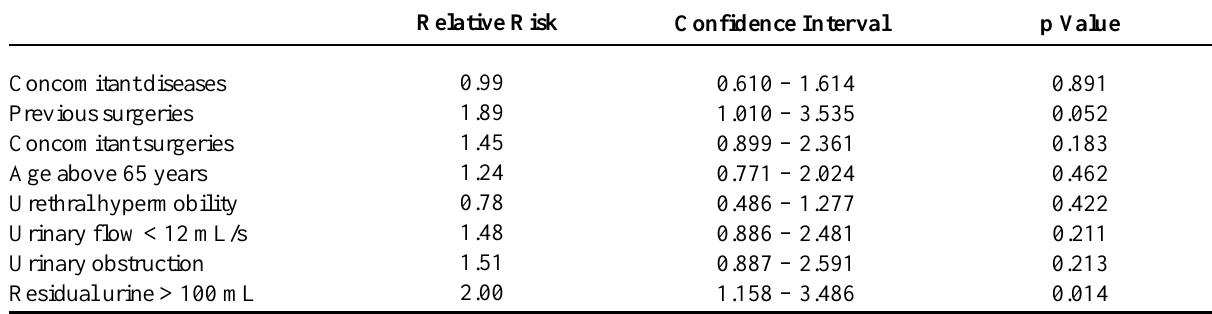
Table 2 – Univariate analysis for different risk factors